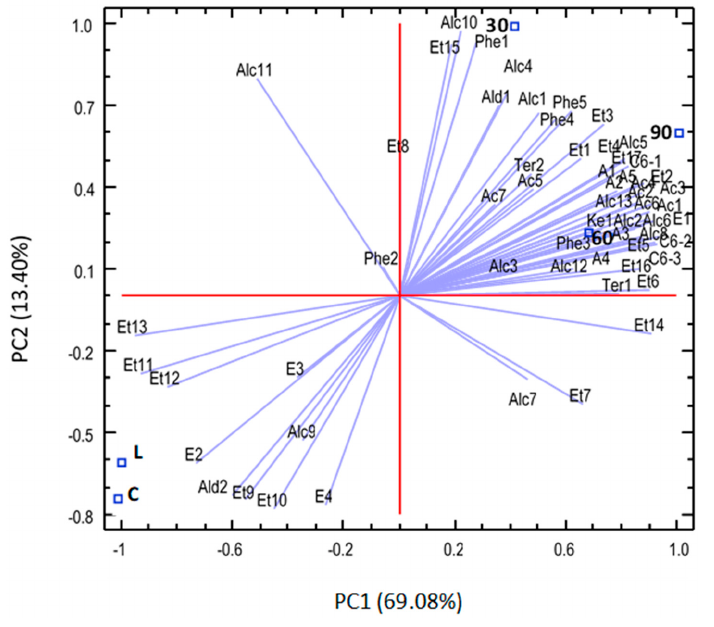
Figure 2. Principal component analysis of wines and volatile compounds. Symbols. C: control; L: ultrasound-untreated lees; 30, 60, 90: ultrasound-treated at an amplitude level of 30%, 60%, and 90%, respectively. Code of volatile compounds (see Table 2).